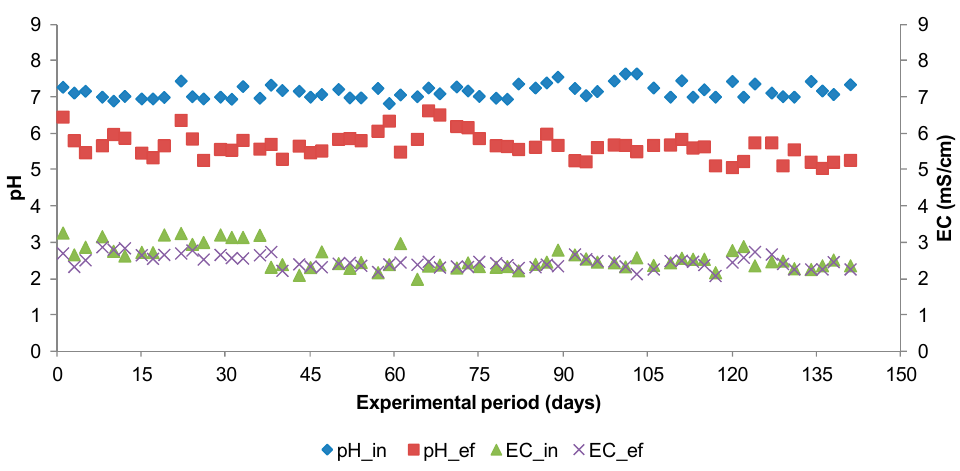
Figure 4. pH and electrical conductivity (EC) patterns in the immobilized cell biofilter treating diclofenac-based wastewater.